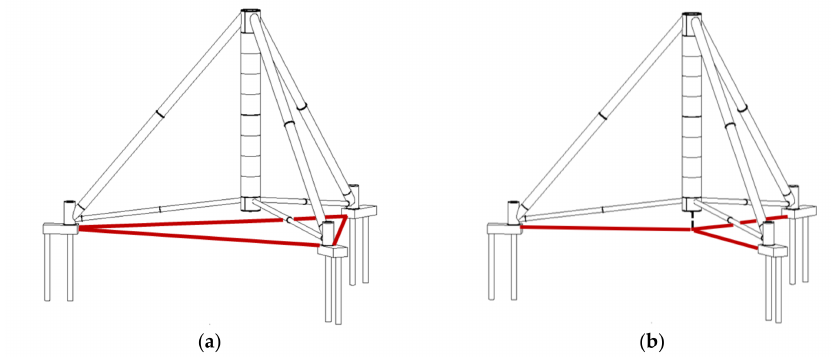
Figure 8. Foundation tie rods: ( a ) triangular arrangement and ( b ) radial